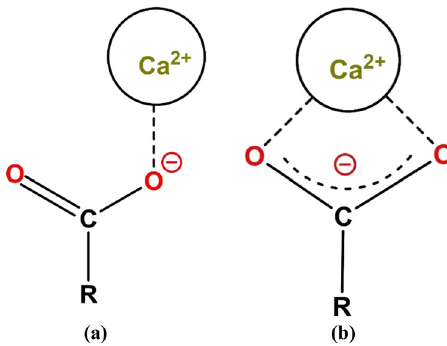
Figure 15: Schematic illustration of two types of coordination between Ca 2 + and – COO − groups: – COO − as a ( a ) monodentate; or ( b ) bidentate ligand.